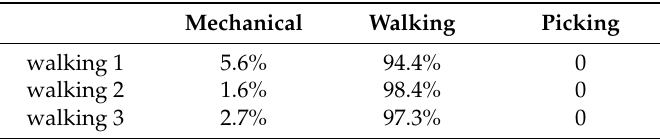
Table 3. The identification rate of walking